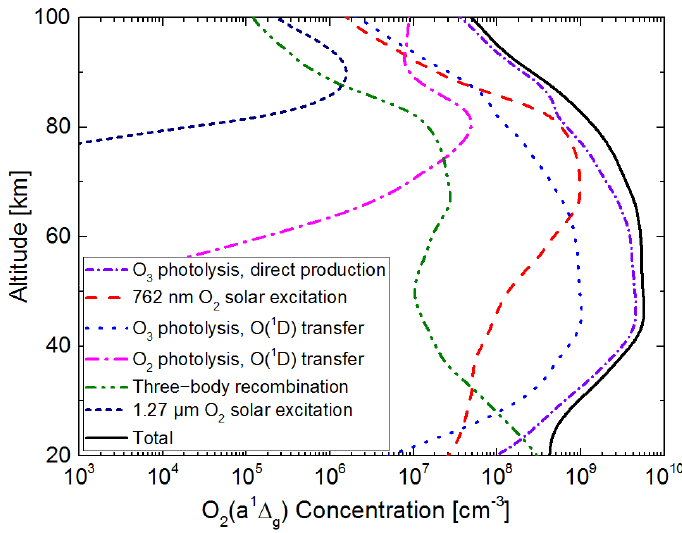
1 ∆ g ) concentration profiles for different production 2 (a